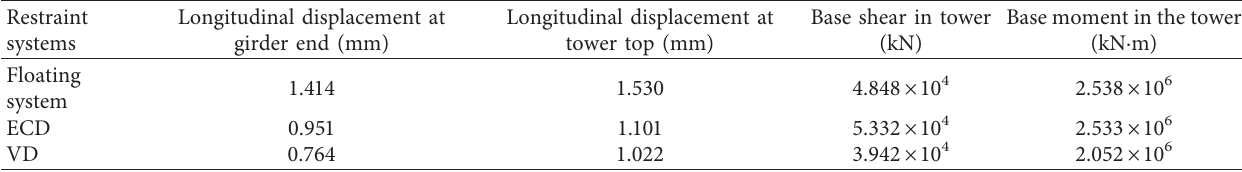
Table 3: Comparison of longitudinal internal forces and displacements with different mitigation measures.